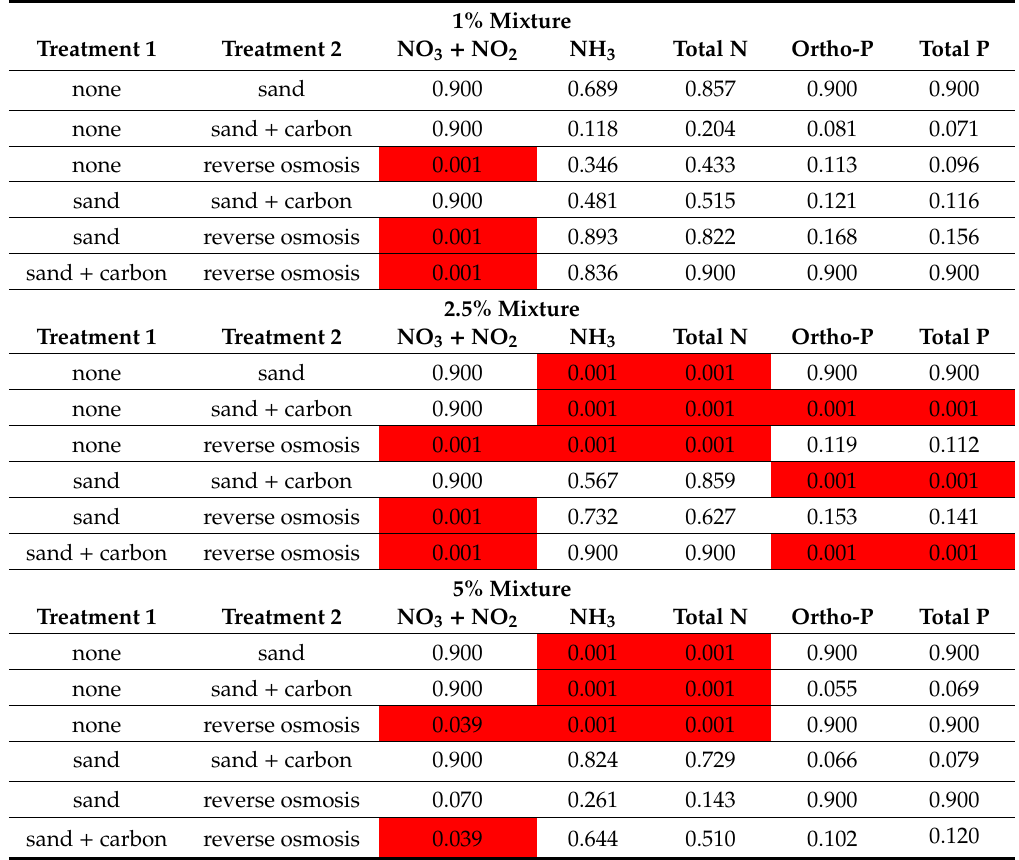
Table 8. Significant di ff erences between methods for each form of nitrogen and phosphorus were calculated using the Tukey HSD method, and the p -values are presented for each treatment comparison. Significant di ff erences ( p < 0.05) are highlighted in red for